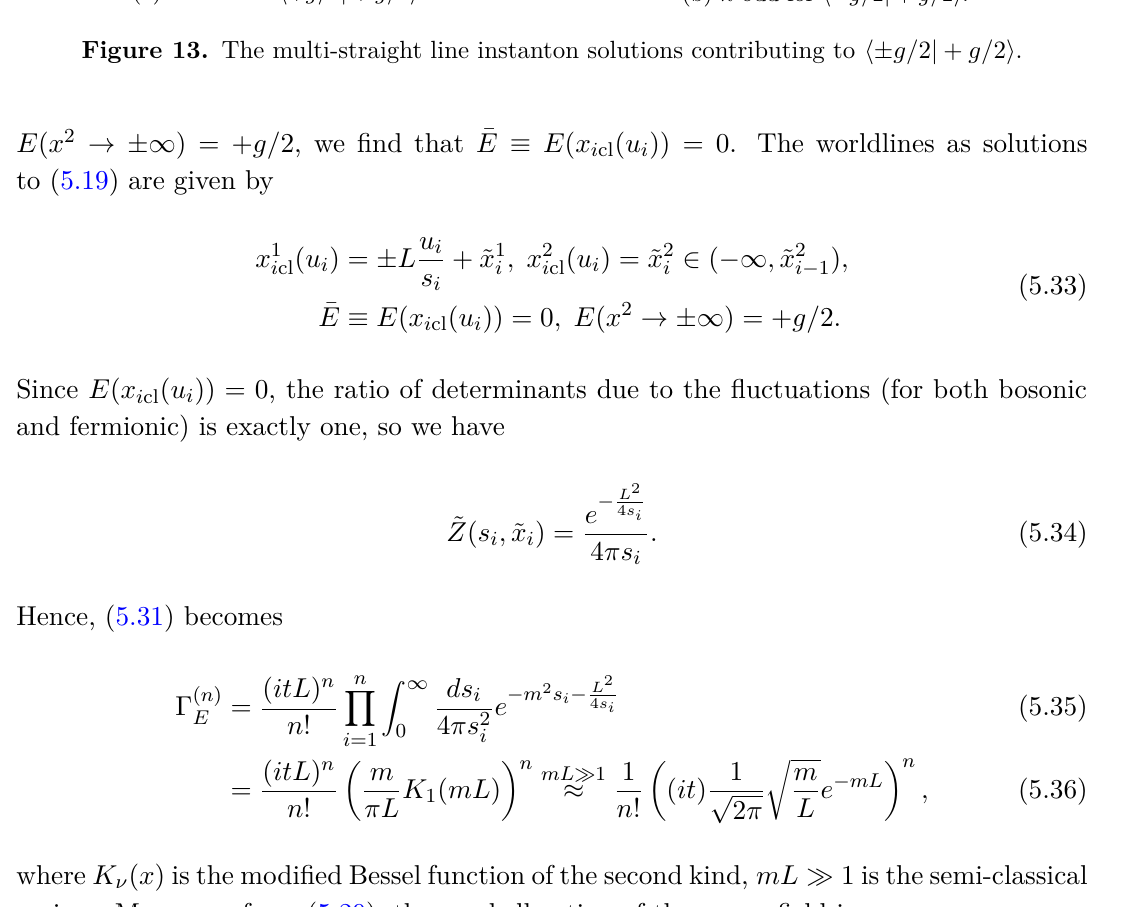
Figure 13. The multi-straight line instanton solutions contributing to h± g/ 2 | + g/ 2 i .